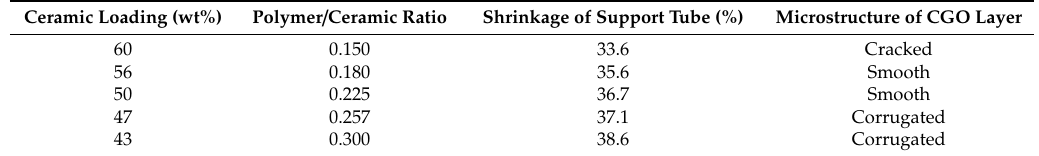
Table 1. Shrinkage comparison of the coated support tubes fabricated from slurries with different ceramic loadings.